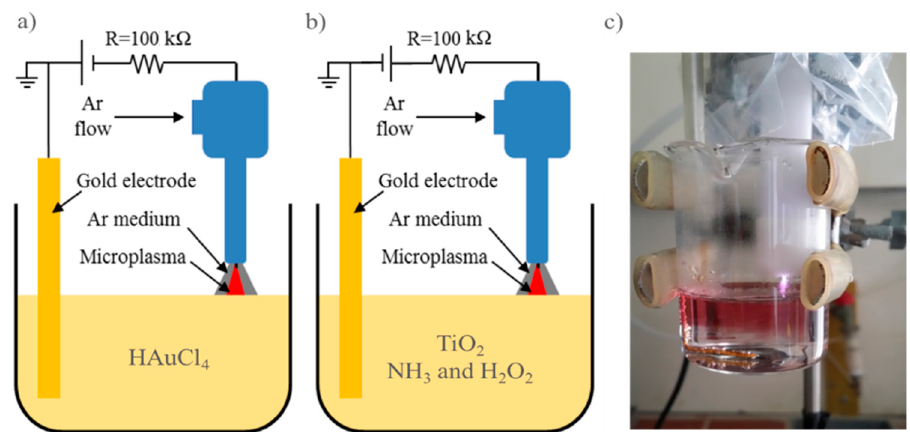
Figure 1. Micro-plasma discharge workstation for ( a ) the electrochemical gold reduction, ( b ) the TiO 2 treatment, and ( c ) the image of the running plasma for gold nanoparticle synthesis from a HAuCl 4 0.06 mM precursor solution.